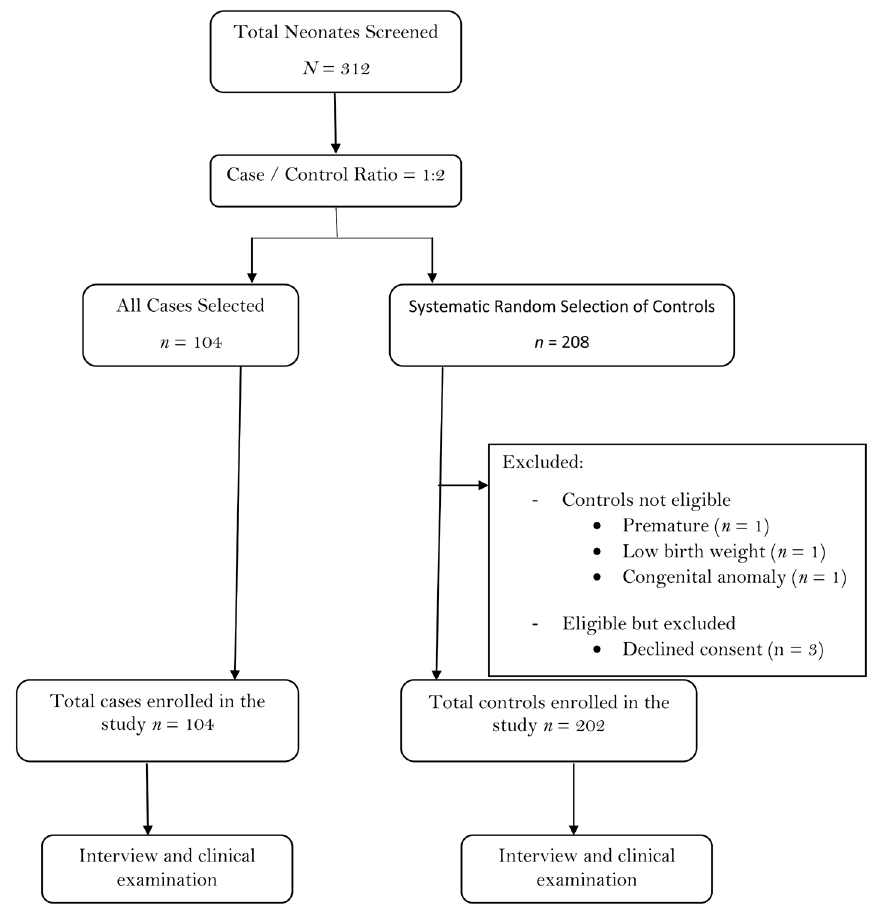
Figure 2. Study flow